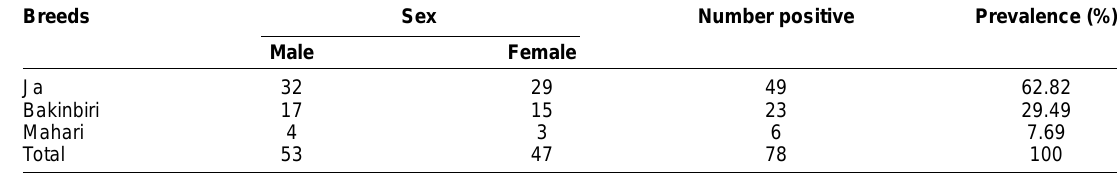
Table-4. Prevalence of gastrointestinal parasites of camels by breeds in Sokoto metropolis. Breeds